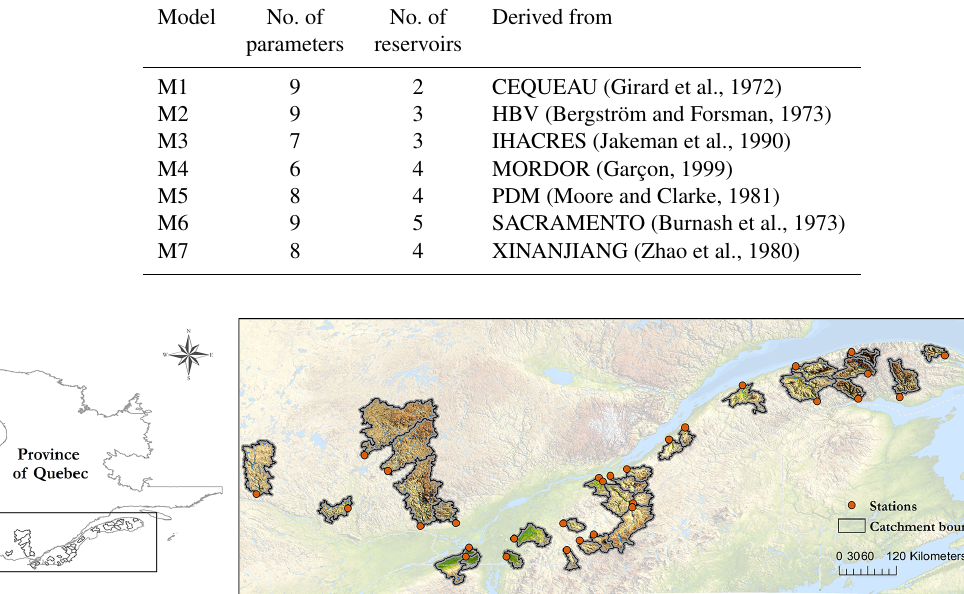
Figure 2. Spatial distribution of the 30 studied catchments. Data layers: Direction d’Expertise Hydrique du Québec: catchment boundary, open hydrometric stations, province of Quebec delimitation. Generated by Emixi Valdez, 23 May 2021, using ArcGIS for Desktop Advanced, version 10.4. Redlands, CA: esri,